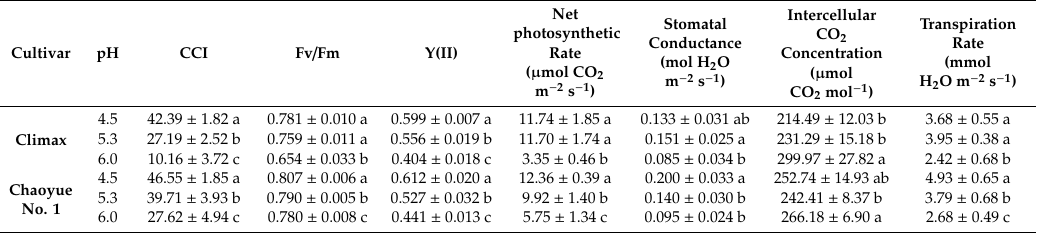
Table6. E ff ectofdi ff erentpHtreatmentsonchlorophyllcontentindex(CCI),themaximalphotochemical e ffi ciency of PSII (Fv / Fm), quantum photosynthetic yield of PSII (Y(II)), and gas exchange parameters in leaves of two